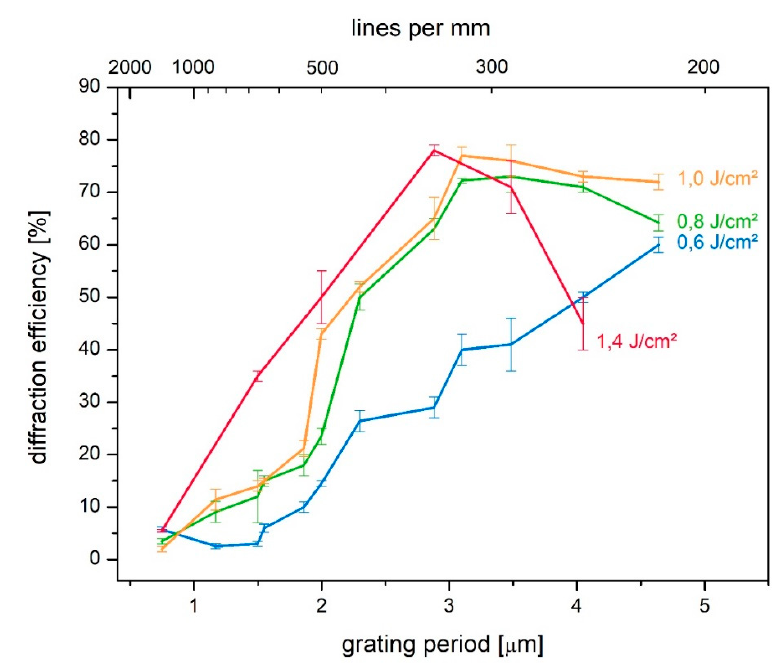
Figure 2. Spatial frequency response for transmission-type gratings under variation of the exposure dose.